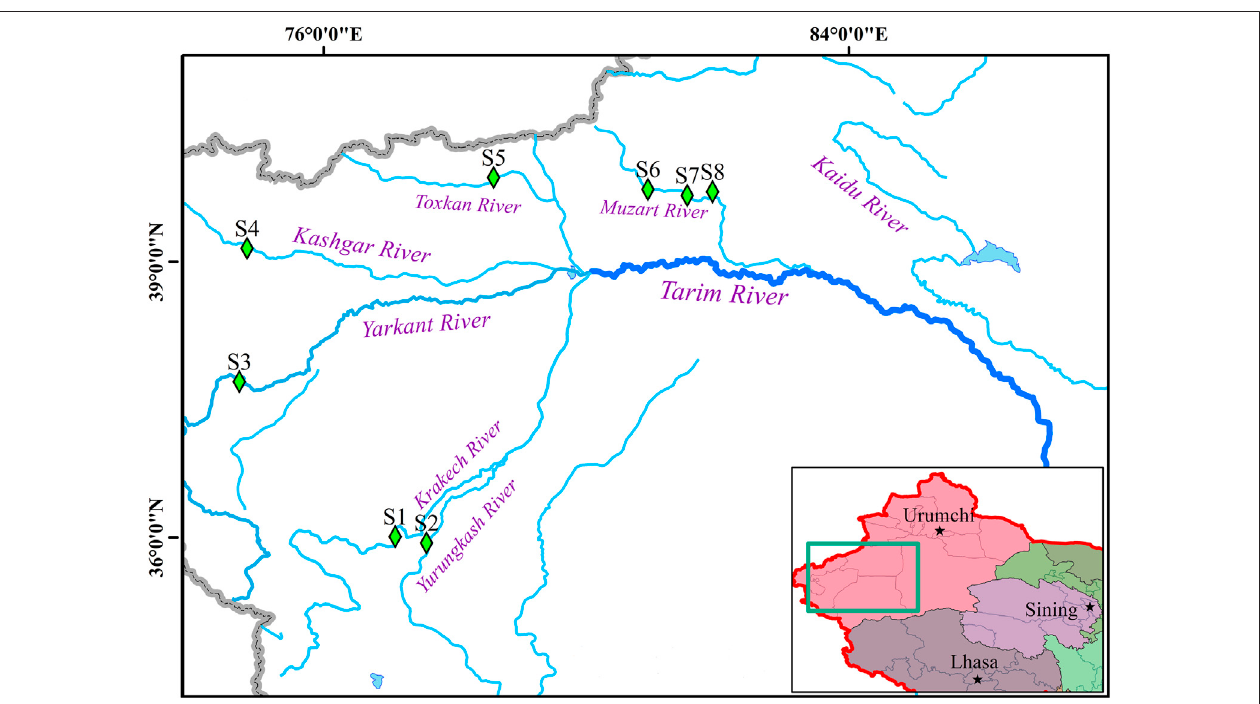
FIGURE 1 | The distribution of T. tenuis populations in the branches of the Tarim River. The blue lines represent the rivers. The green square symbols indicate the sampling locations. S1, WLWF; S2, LF; S3, AETS; S4, SF; S5, WS; S6, DWQ; S7, TKX; S8, KZE.